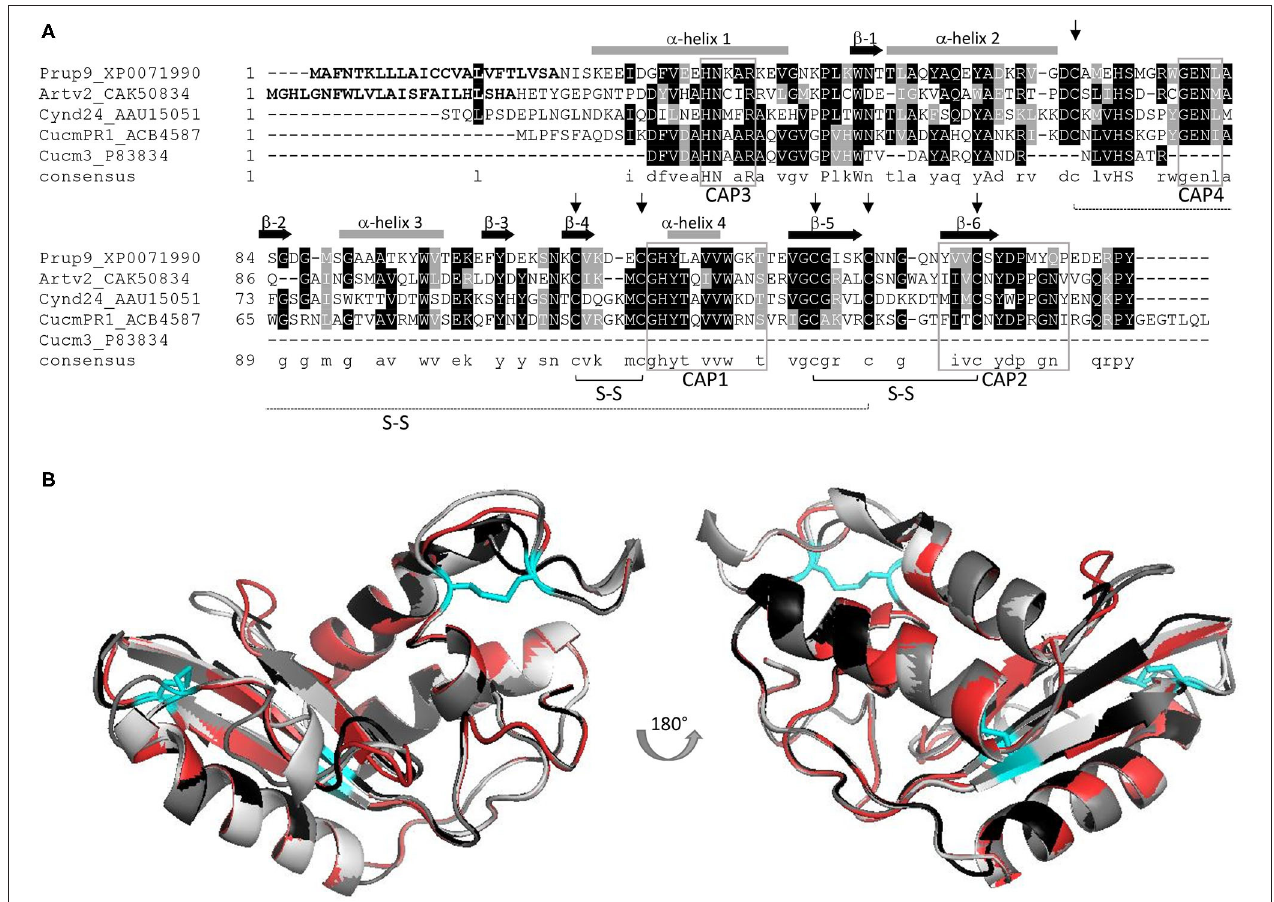
FIGURE 1 | (A) AA alignment of PR-1 allergens Pru p 9, Art v 2, Cyn d 24, and Cuc m 3, including the full-length sequence of a Cuc m PR-1 protein; signal peptides of Pru p 9 and Art v 2 are displayed in bold; six conserved cysteins are indicated by an arrow, and the corresponding S-S bonds are outlined; CAP signature motifs 1–4 are marked (gray box) and α -helix (gray bar) and β -sheets (black arrow) are included; consensus sequence: conserved aa: capital letters, similar aa: small letters, no similarity: no letter; Figure adapted from (7). (B) Superimposition of 3D models including Pru p 9 (red), Art v 2 (black), Cyn d 24 (gray), and Cuc m PR1 (light gray). Disulfide bonds are indicated in cyan. All proteins were modeled using Swiss model and P14a from Lycopersicon esculentum (PDB-1CFE) as